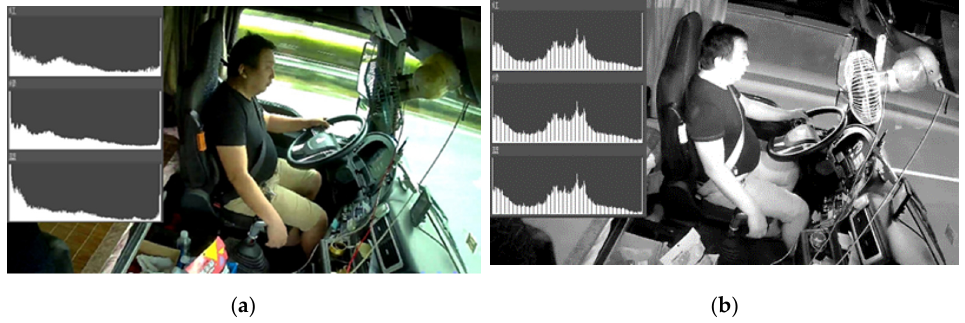
Figure 8. Images and their histogram features: ( a ) daytime image; ( b ) night image.